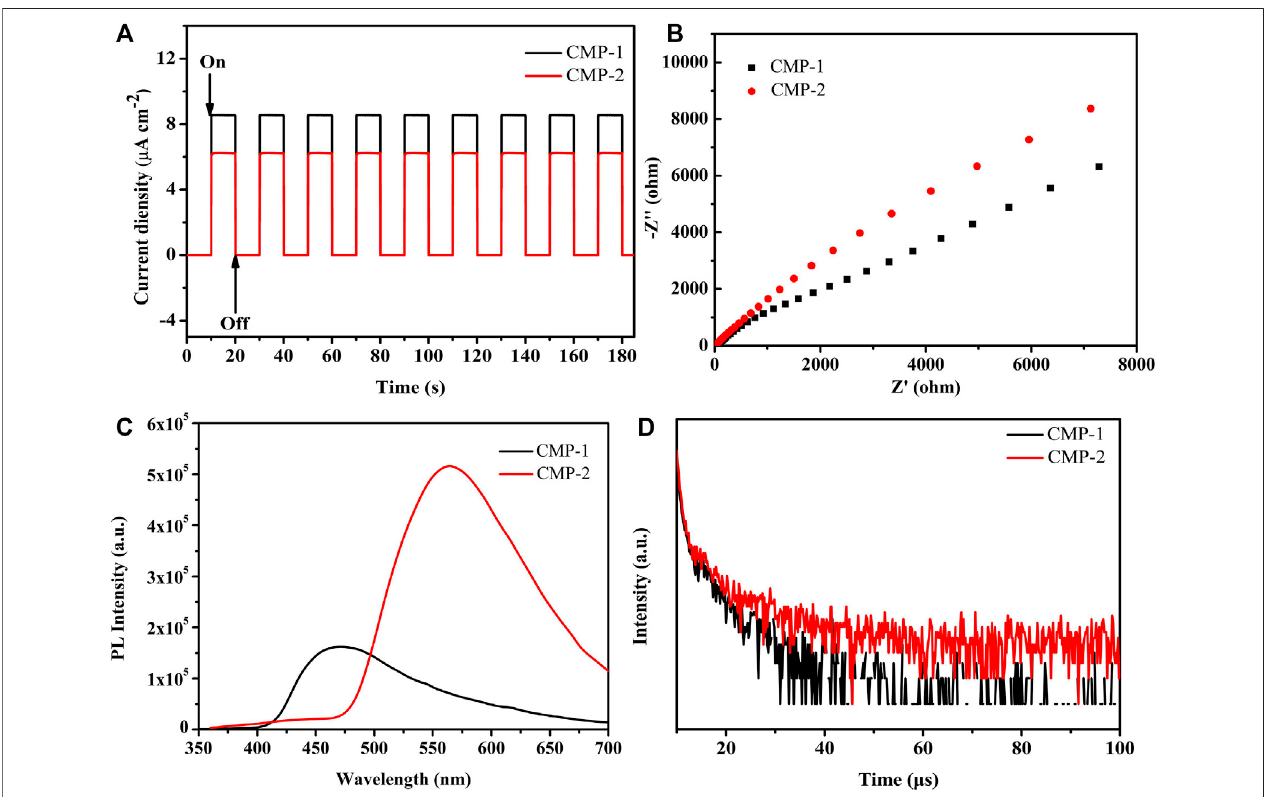
FIGURE 6 | (A) Photocurrent of the CMPs (in 0.5 M Na 2 SO 4 ); (B) EIS Nyquist plots of the CMPs; (C) PL spectra of the CMPs; (D) time-resolved PL spectra of the CMPs.